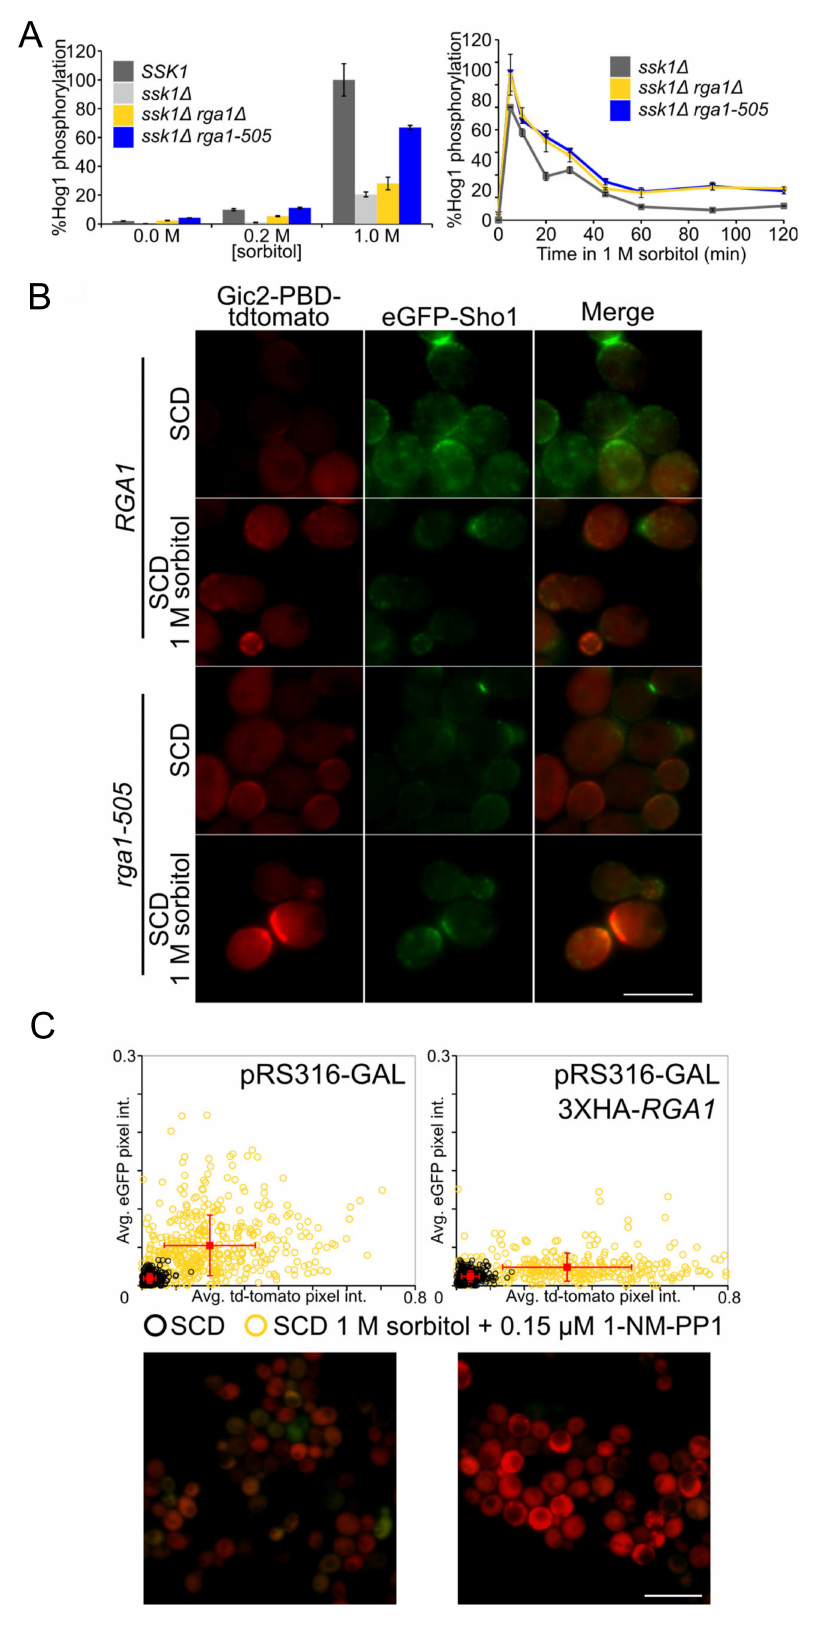
Figure 5. Rga1 negatively regulates the Sho1 branch of the HOG MAPK pathway. ( A ) Strains